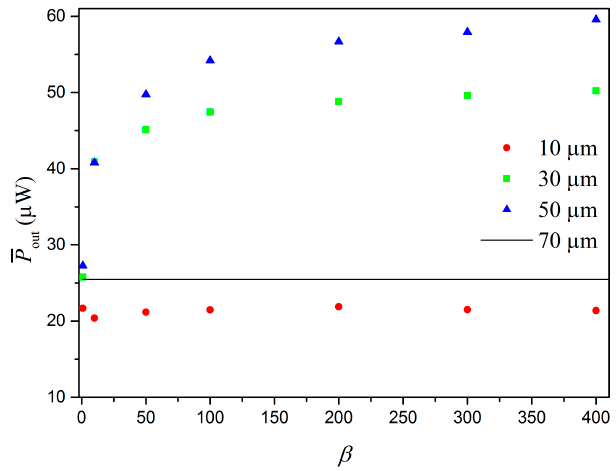
Figure 9. Average harvested power output for different frequencies (interval of 500 to 1400. rad/s), for different values of gap, as a function of β .